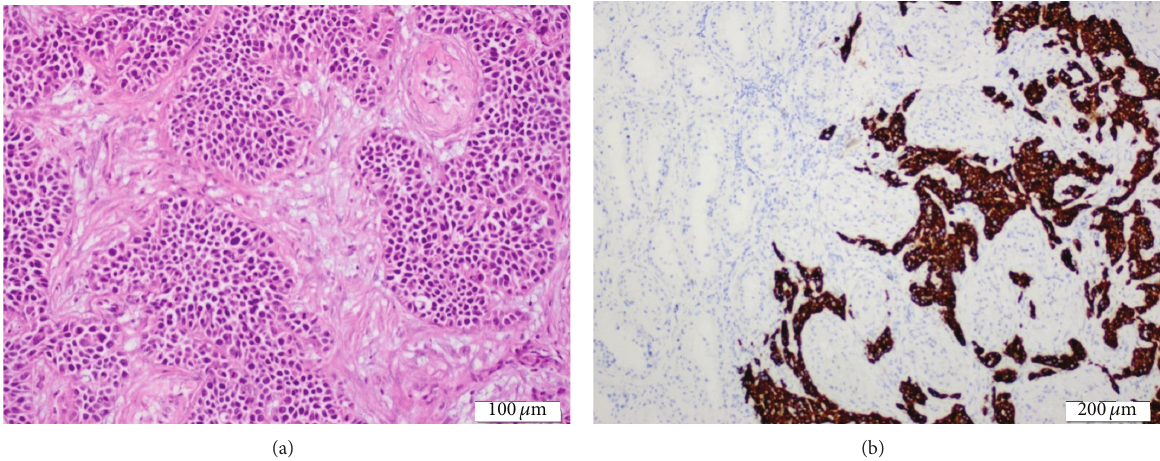
Figure 3: Histopathologic findings of UC metastasis to the left testis ((a) hematoxylin and eosin x20 and (b) cytokeratin